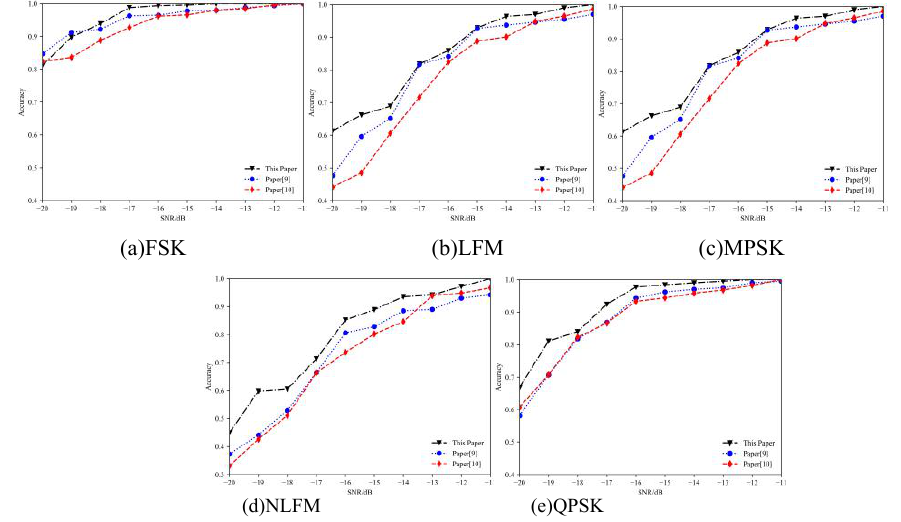
Fig. 4. Different radar signal recognition accuracy rate under different